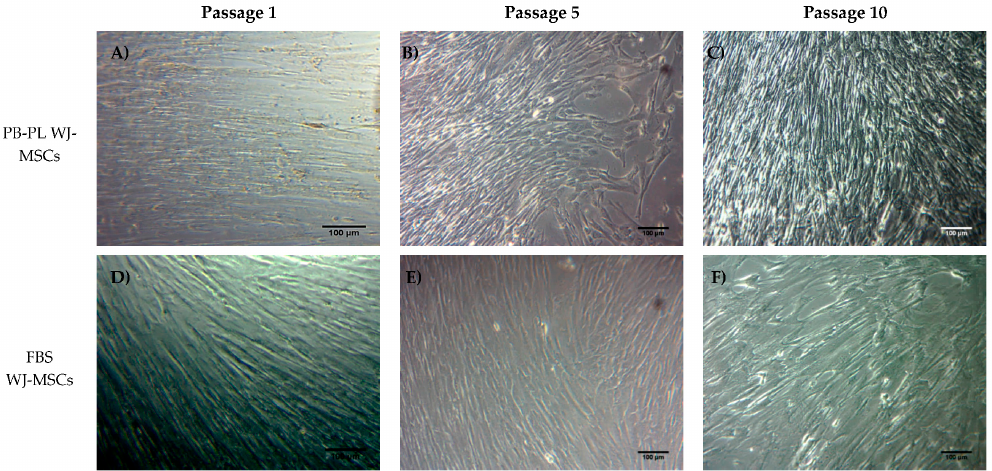
Figure 2. WJ-MSCs in culture at passage 1, 5 and 10. MSCs either with FBS or PB-PL growth medium achieved to retain their morphology until reaching passage 10. PB-PL expanded WJ-MSCs at passage 1 ( A ), 5 ( B ) and 10 ( C ). FBS expanded WJ-MSCs at passage 1 ( D ), 5 ( E ) and 10 ( F ). Original magnification 10×, scale bars 100 μ m. Table 3. Cell culture kinetics of FBS and PB-PL expanded WJ-MSCs.